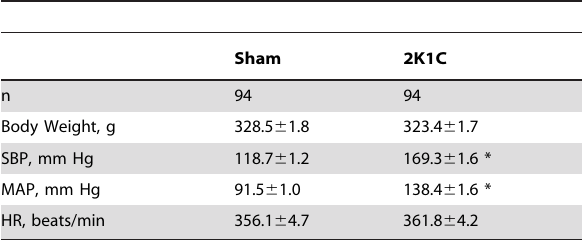
Table 1. Body weight, SBP, MAP and HR at the end of the 4th week.